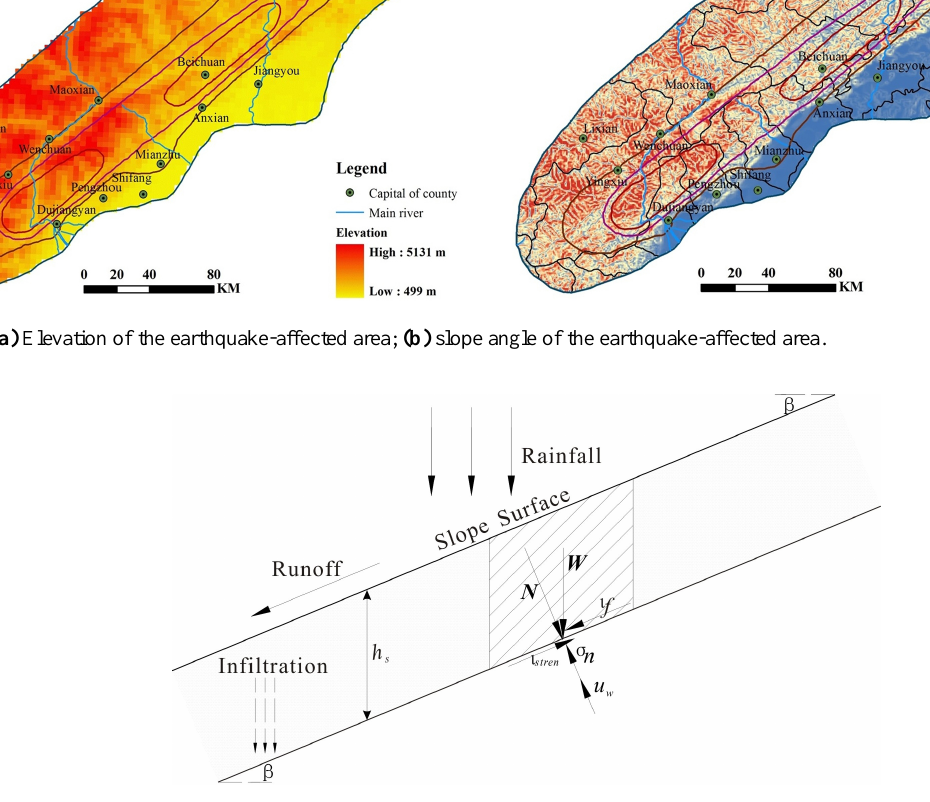
Figure 3. Analysis of soil mass stability influenced by rainfall